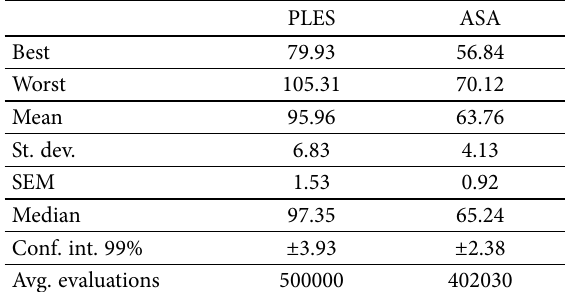
Table 8. Performance of the PLES and the ASA